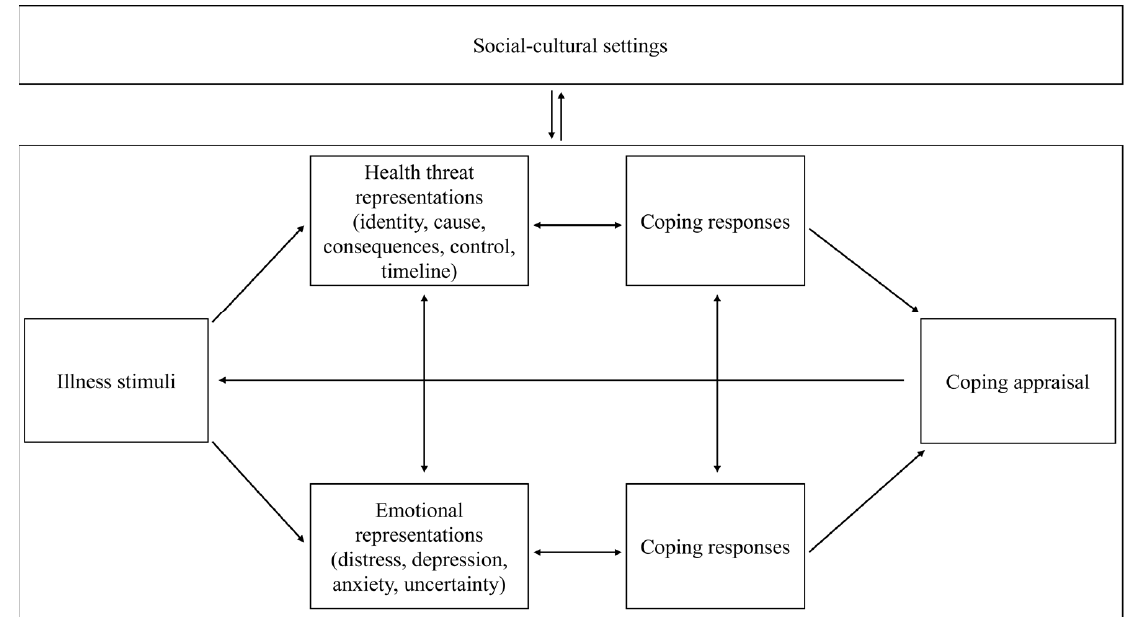
Figure 1. Common-Sense Model of Illness Representation.